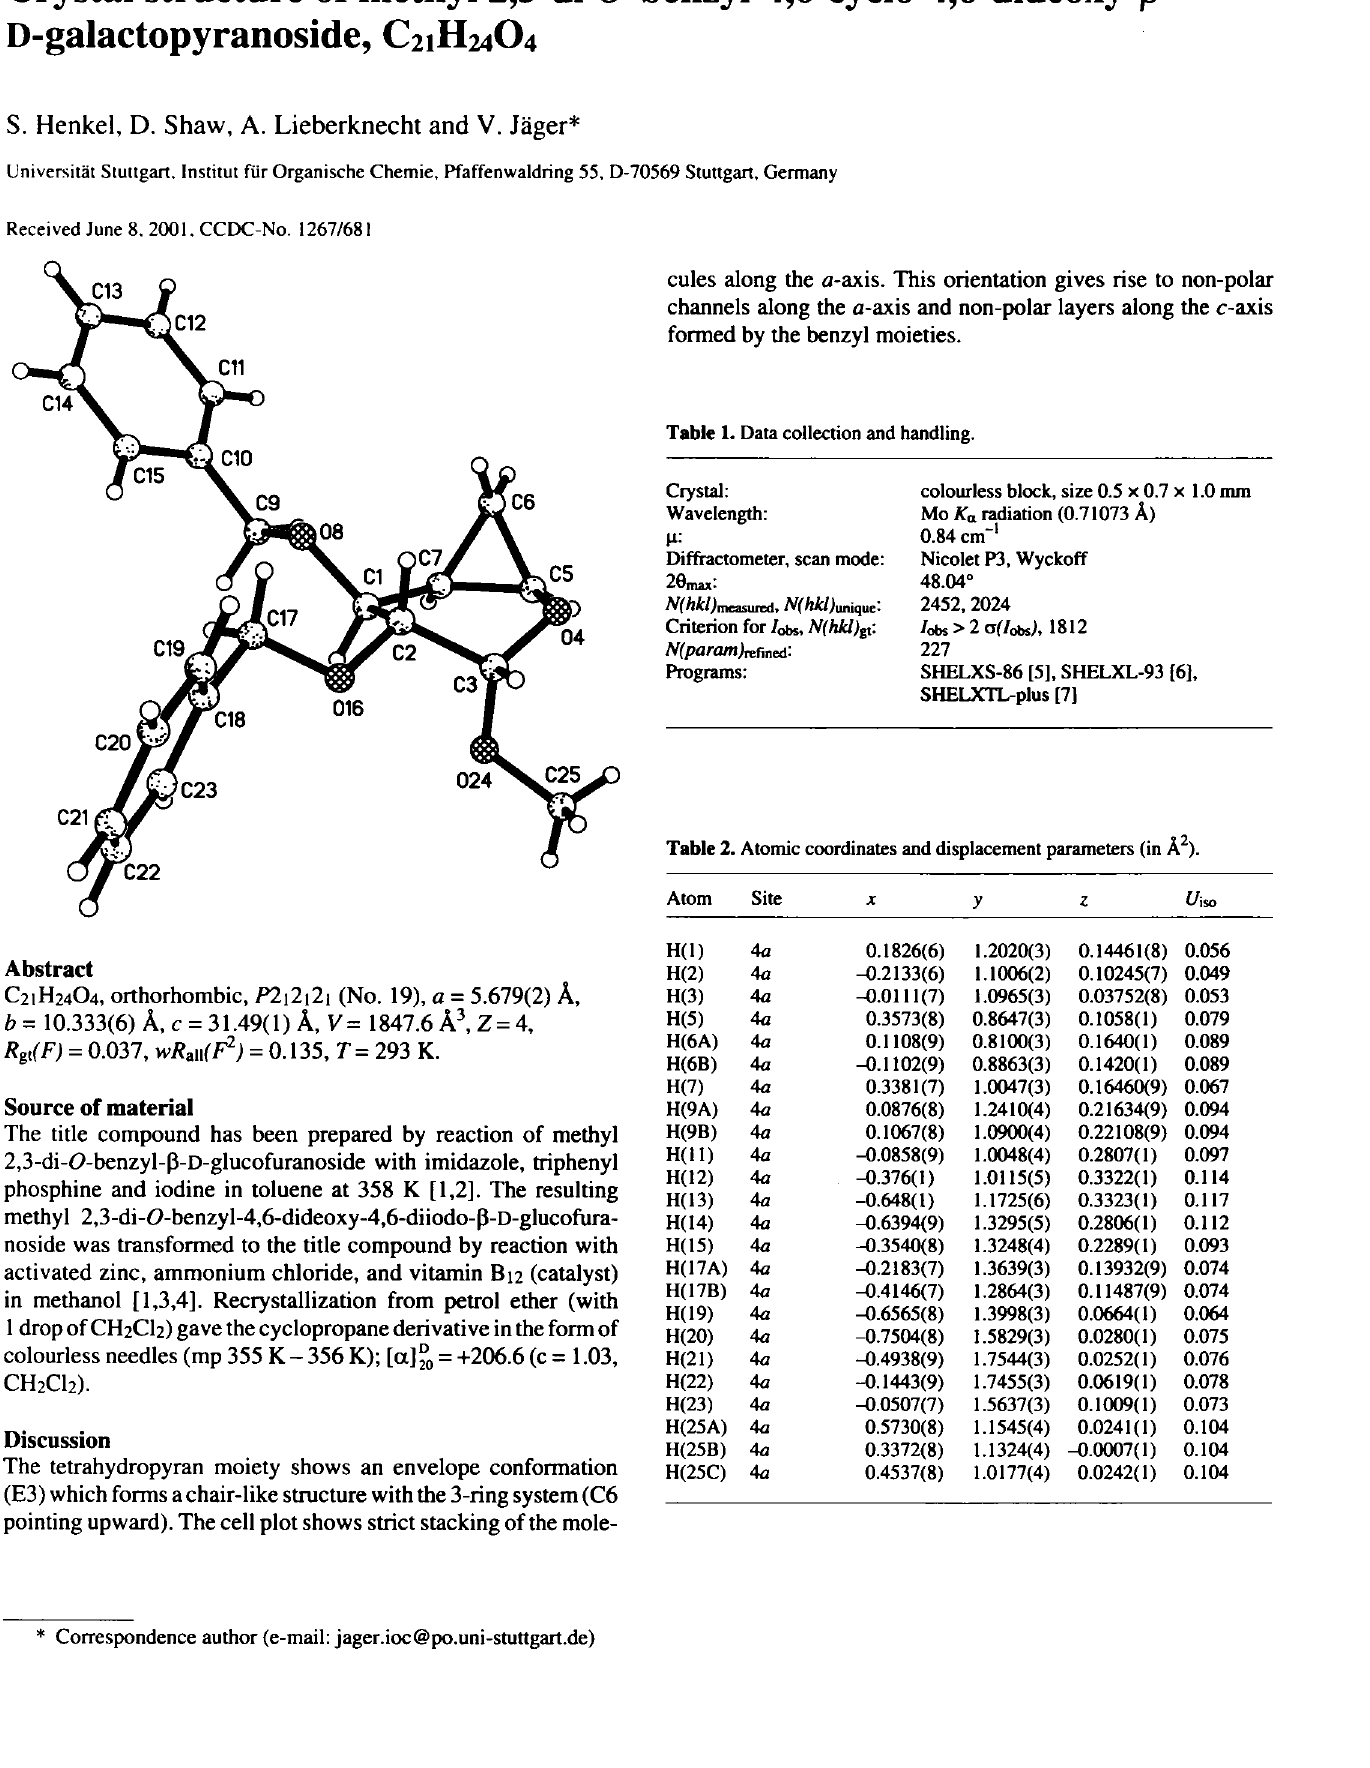
Table 1. Data collection and handling.